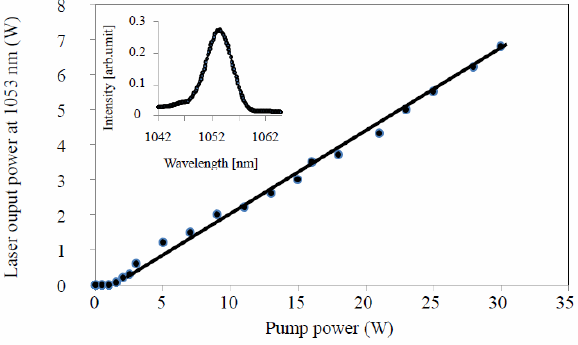
Fig. 7 Laser output at 1052.8 nm versus pump power, the top left if the laser spectrum